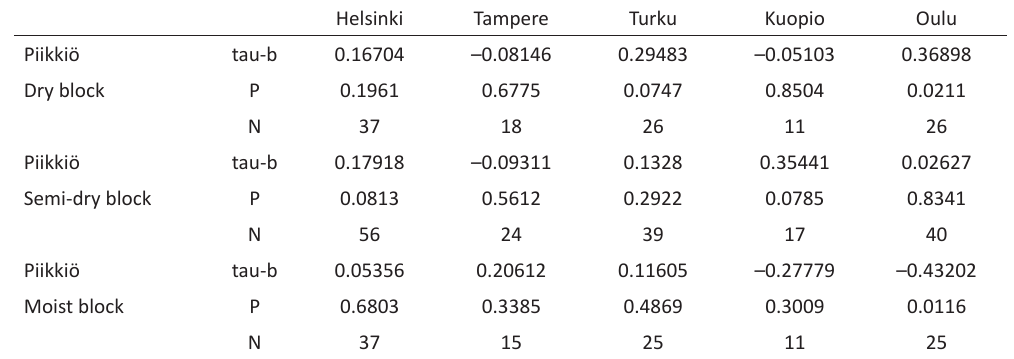
Table 7. Kendall’s tau-b on mean seedling emergence (1 m -2 ) in moisture controlled field experiment in dry, semi- dry and moist blocks with mean scores of seedling emergence each common garden city in 2005–2010